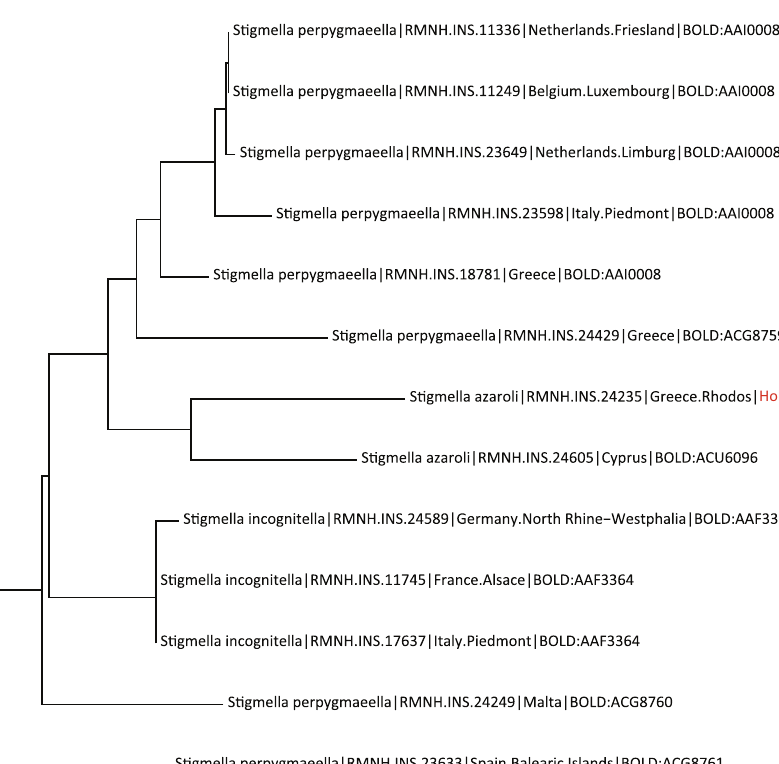
Figure 76. Neighbor Joining tree of DNA Barcodes of the Stigmella incognitella group, showing the paraphyly with regards to S. azaroli and S. incognitella and large distances for specimens identified as Stigmella perpygmaeella from Malta and Mallorca. Specimens from Cyprus are identified as S. azaroli , of which the holotype from Rhodos was also